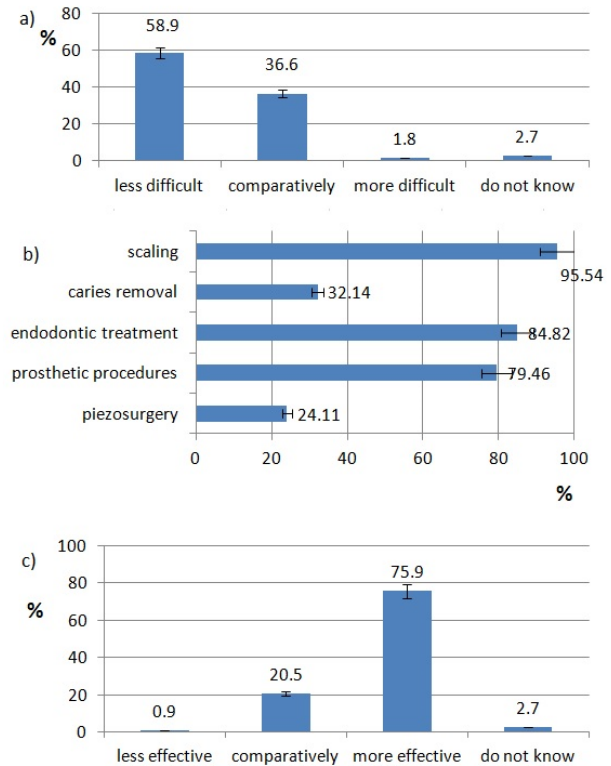
Figure 3. Ultrasounds use pattern of responding dentists; ( a ) difficulty of ultrasonic procedures, ( b ) type of ultrasonic procedures, ( c ) effectiveness of ultrasonic procedures.